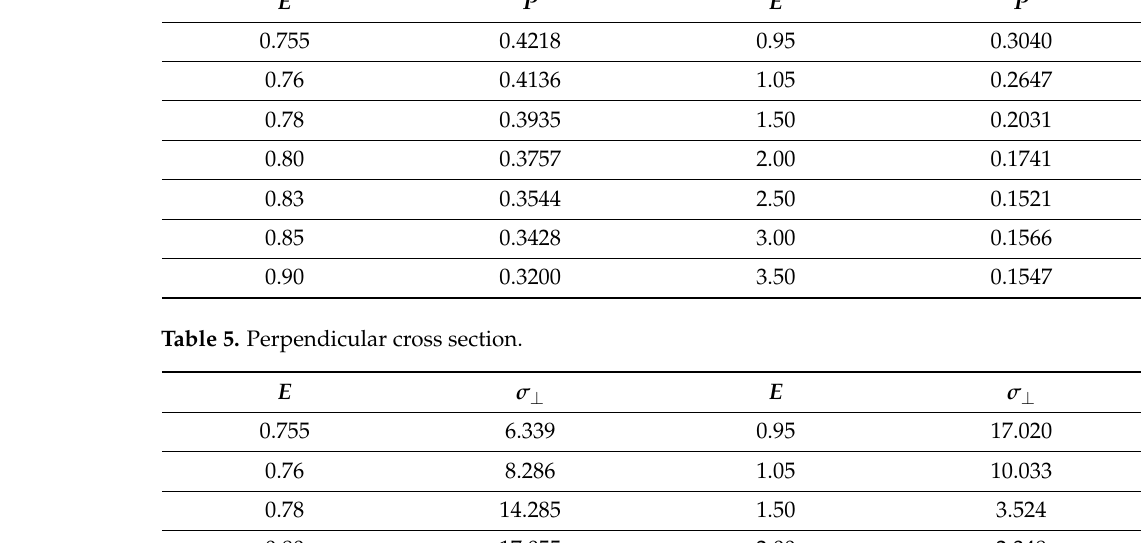
Table 4. Polarization of radiation.